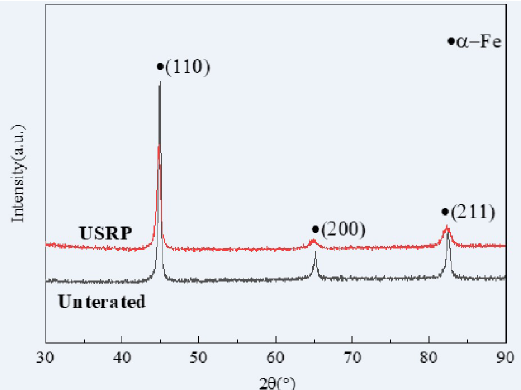
Figure 14. Tafel curves of GCr15 material surface before and after